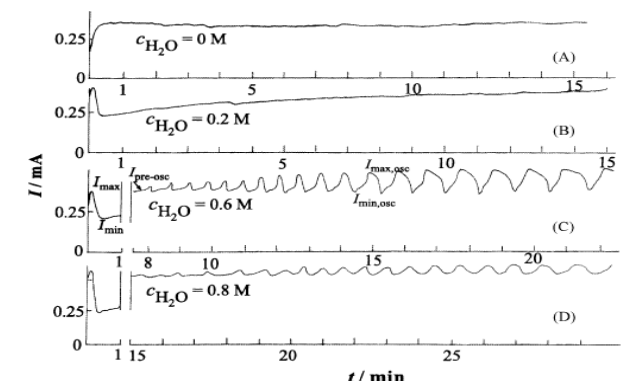
Fig. 4. The current responses, observed during potentiostatic electropolymerization of indole over iron in ACN-Water mixtures without (a, b) and with (c,d) oscillatory behavior. Reproduced from [24] with the permission of Elsevier, the Netherlands.